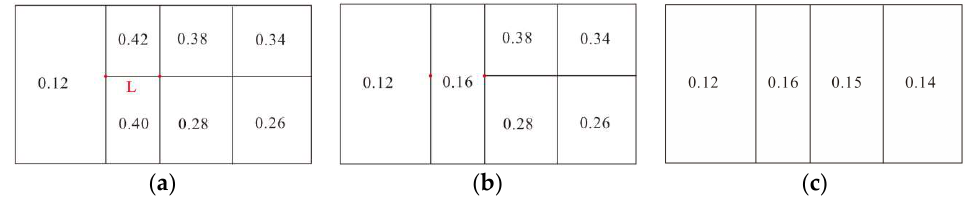
Figure 2. Schematic diagram of the mesh-based method: ( a ) original road network, ( b ) first-stage elimination result of the mesh-based method and ( c ) final elimination result of the mesh-based method. The flowchart is shown in Figure 3.